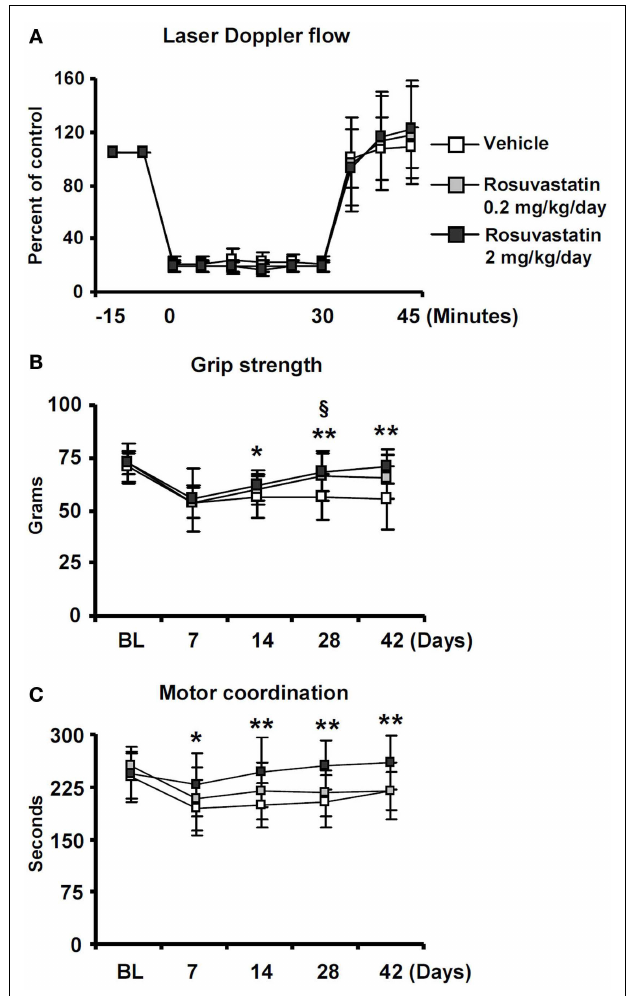
FIGURE 1 | Delayed delivery of rosuvastatin at a dose of 2mg/kg/day, but not 0.2mg/kg/day, promotes post-ischemic recovery of grip strength and motor coordination . (A) Laser Doppler flow (LDF) recordings above the core of the middle cerebral artery territory, (B) grip strength of the lesion-contralateral right paretic forepaw, and (C) motor coordination evaluated by RotaRod tests of ischemic mice treated with vehicle or rosuvastatin (0.2 or 2mg/kg/day i.c.v.) starting at 72h post-ischemia. Note that motor force (B) and coordination skills (C) , which are compromised following stroke, do not exhibit any major improvements over time in vehicle-treated mice and mice receiving rosuvastatin at a dosage of 0.2mg/kg/day, but progressively improve over 14–42days in animals treated with rosuvastatin at a 2mg/kg/day dosage. LDF measurements (A) , which were recorded for evaluating the reproducibility of ischemia, do not differ between groups. BL, baseline. Data are